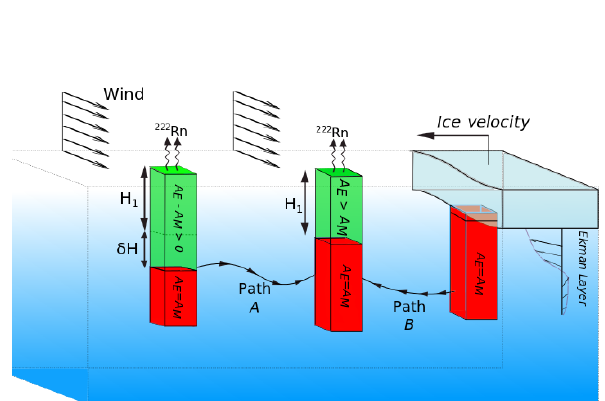
Figure 1. A graphic illustration of two possible back trajectories for a single sampling